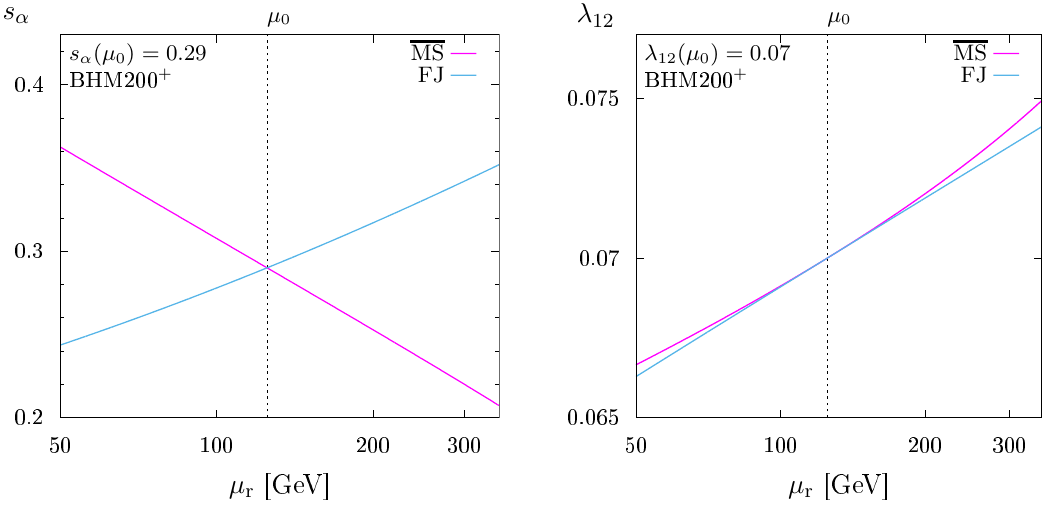
Figure 10 . The running of the input parameters s (cid:11) and (cid:21) 12 in the MS and FJ renormalization schemes for benchmark scenario BHM200 +